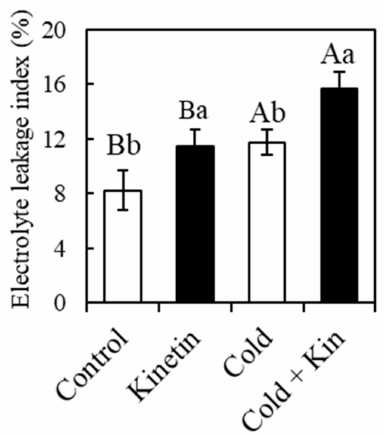
Figure 1. E ff ect of exogenous kinetin on the electrolyte leakage index in the leaves of co ff ee plants under optimum and cold stress conditions. Optimum temperature, 25 / 20 ◦ C, whereas cold stress conditions, 12 / 12 ◦ C. Kin, kinetin. Di ff erent capital letters, (A, B) denote statistically significant di ff erences between the parameter means within temperature treatments, whereas di ff erent small letters, (a, b) denote statistically significant di ff erences for the parameter means within kinetin treatments ( p < 0.05, Newman–Keuls test). Means are a replicate of three independent samples ( n = 3). Error bars represent standard deviation of the